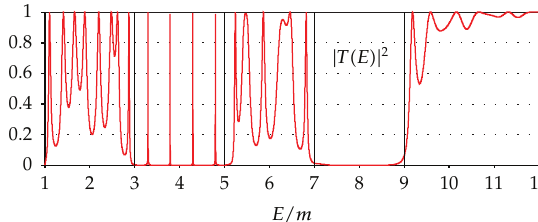
Figure 7: The transmission coe ffi cient associated with the potential configuration of Figure 6 as a function of energy for V (cid:2) (cid:9) 4 m , V − (cid:9) 8 m , a (cid:2) (cid:9) 3 /m , and 2 a − (cid:9) 5 /m